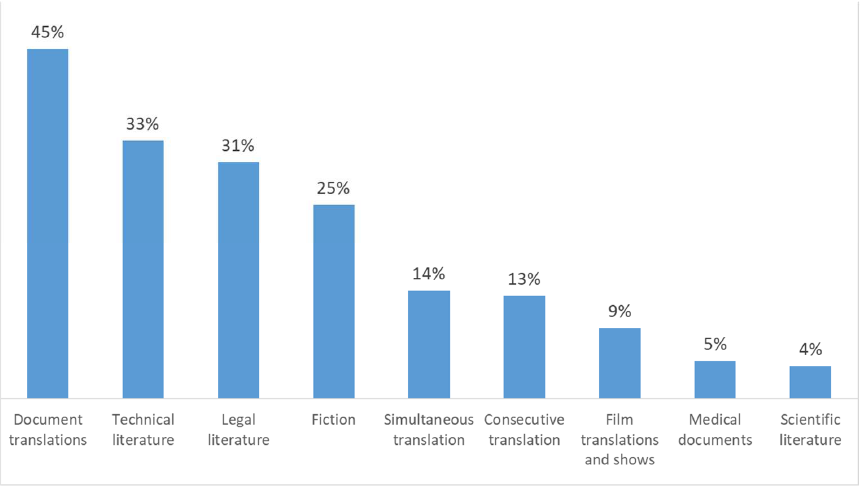
Figure 2. What kind of translations do you specialise in? N = 144.